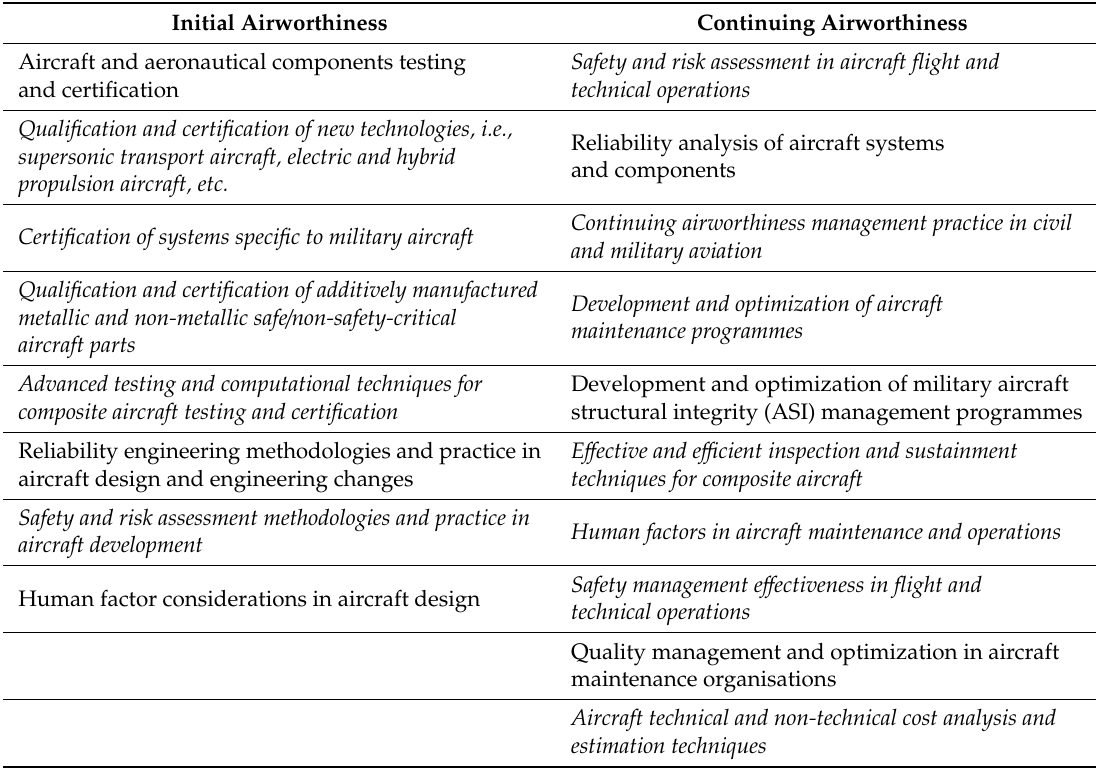
Table 1. Coverage of Special Issue’s targeted theme areas, as indicated with the italic